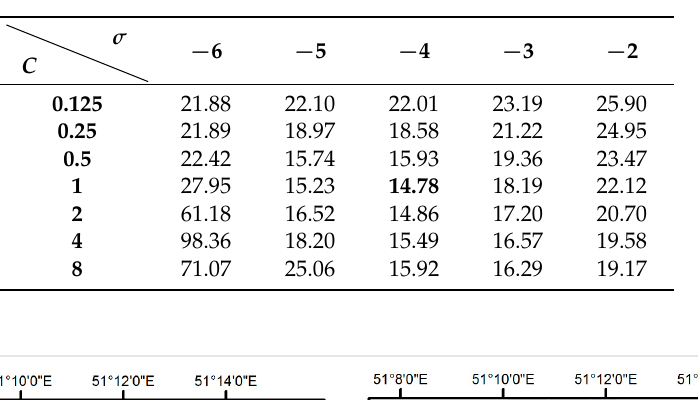
Figure 7. Optimum bandwidth of the LSVM model resulting from the cross-validation error. Table 2. Average RSS values of the GSVM calculated by the ten-fold cross-validation method with σ and C near the optimal values ( C = 1, σ = − 4).